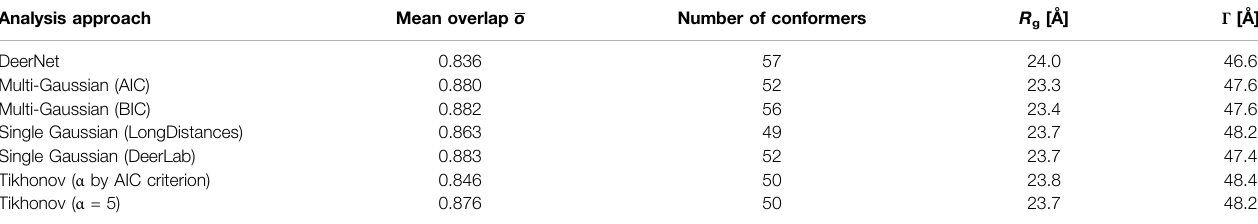
TABLE 3 | Geometric mean overlap o , number of conformers, radius of gyration R g , and ensemble width Γ in ensembles of hnRNP A1 LCD (188 – 320) by using distance distributions computed with different approaches (see also Figure 4 ) in ensemble fi tting from the same raw ensemble. Analysis